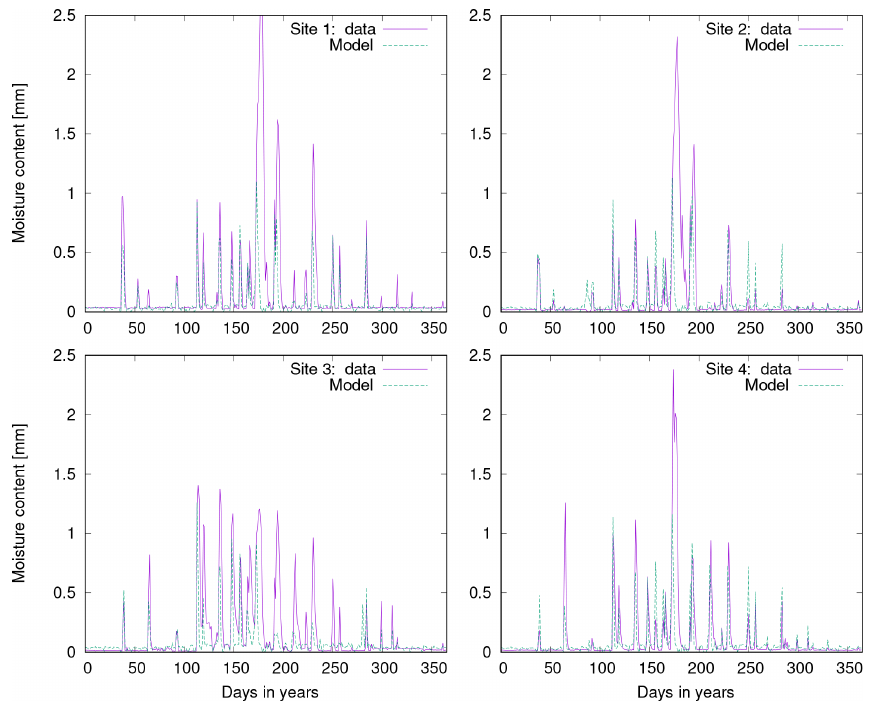
Figure A3. Comparison of measured and simulated moisture content for one biocrust type (dark cyanobacteria-dominated biocrust) and four field sites at Soebatsfontein.